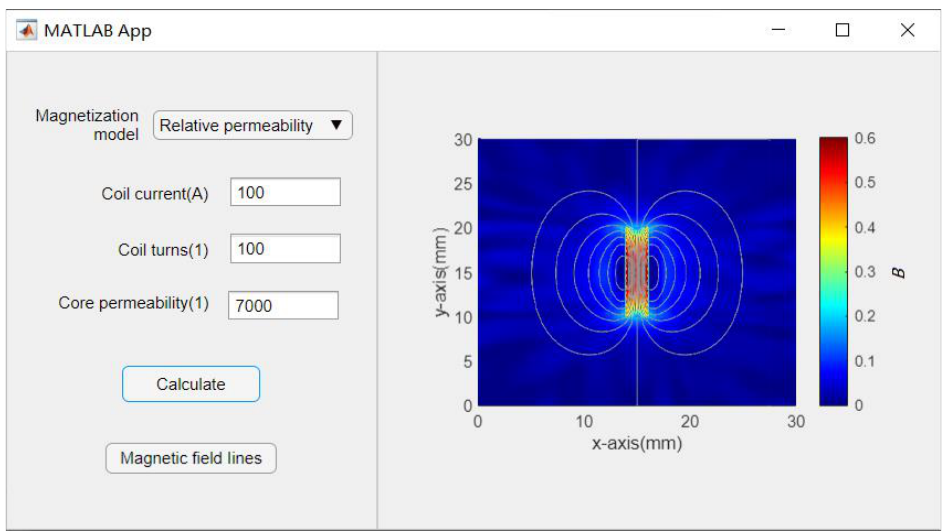
Figure 12. Neural network prediction results when the magnetization model is relative permeability.